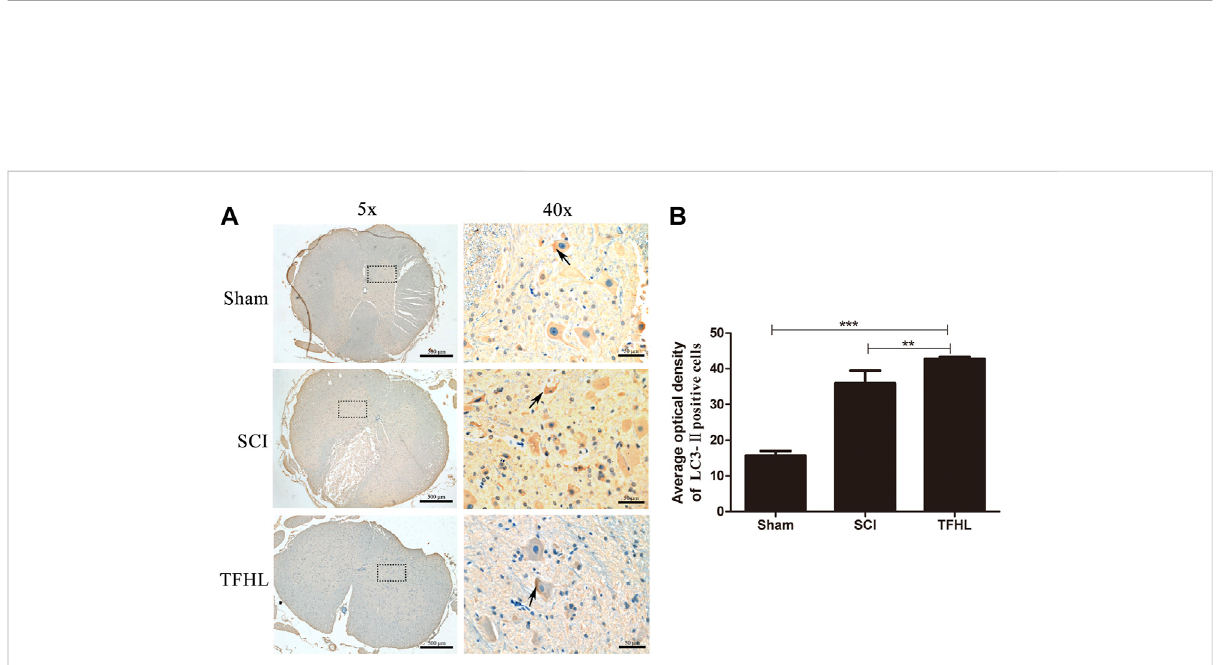
FIGURE 6 TFHL promotes autophagy in injured spinal cord tissues. (A) Observation of autophagy of spinal cord tissues of each group by Immunohistochemistry( n =3,thecross-sectionoftheT10segmentofthespinalcord,scalebars:500and50 μ M).BrownstainingindicatestheLC3- Ⅱ positive cells, as shown by the arrows. The black dashed box in the ×5 magni fi cation is the observation site under ×40 magni fi cation. (B) The average optical density of LC3- Ⅱ positive cells in spinal cord tissues of each group. All data are expressed as the mean ± SD. Differences among groups were determined with one-way ANOVA followed by a least-signi fi cant difference post hoc test. * p < 0.05, ** p < 0.01, *** p <